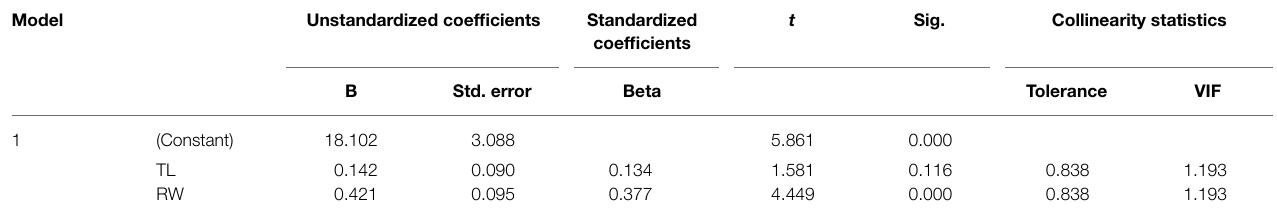
TABLE 6 | Collinearity diagnostic result. Model